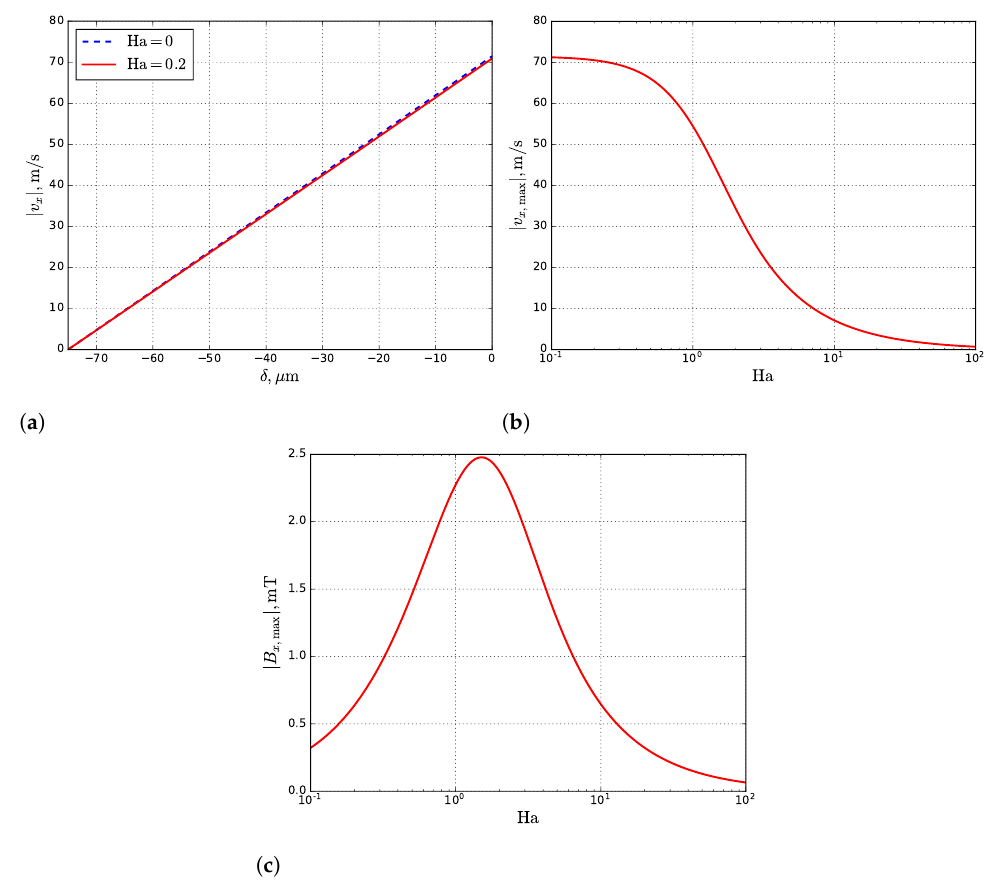
Figure 7. The profiles of fluid velocity ( a ) inside the molten pool, given by Equation (17) at corre- sponding Ha, and semi-log plots of the maximum of fluid velocity ( b ) at the gas–liquid interface ( z = 0), given by Equation (17), and induced MF ( c ) at the liquid–solid interface ( z = − δ ), given by Equation (18) for the different